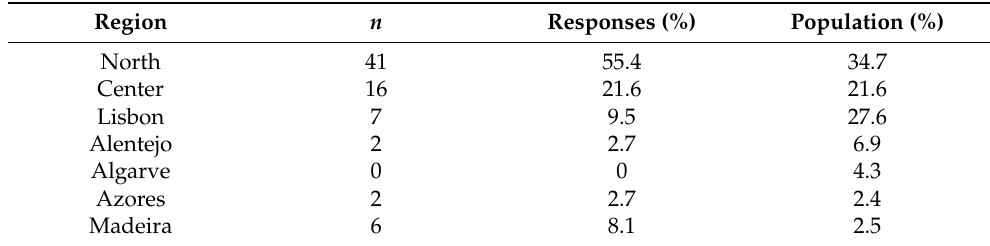
Table 1. Population percentage in survey responses (%) compared to real population distribution (%), adapted from Pordata (2018)